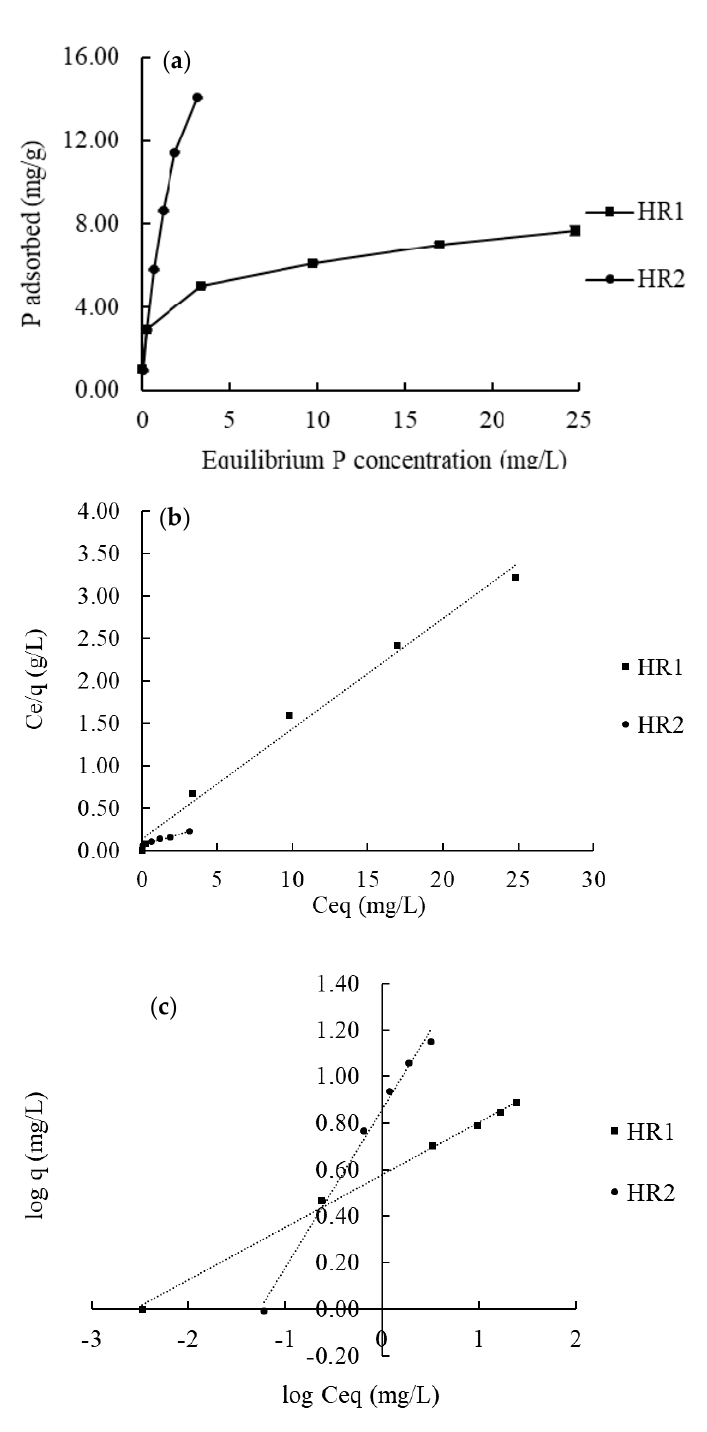
Figure 3. ( a ) Phosphate adsorption isotherm at pH 7.5 in FerrIX™A33E (HR1), and Hybrid IRA67 (HR2). ( b , c ) Show the linear fitting of the isotherm data in Langmuir model and Freundlich model, respectively.